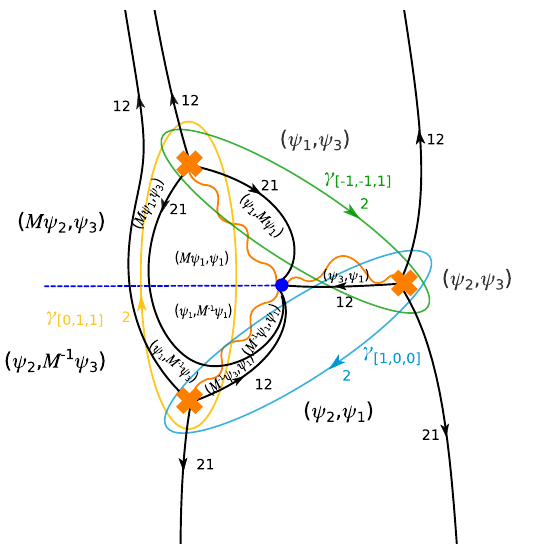
(cid:0) 1 + 1 i (cid:1) , with 10